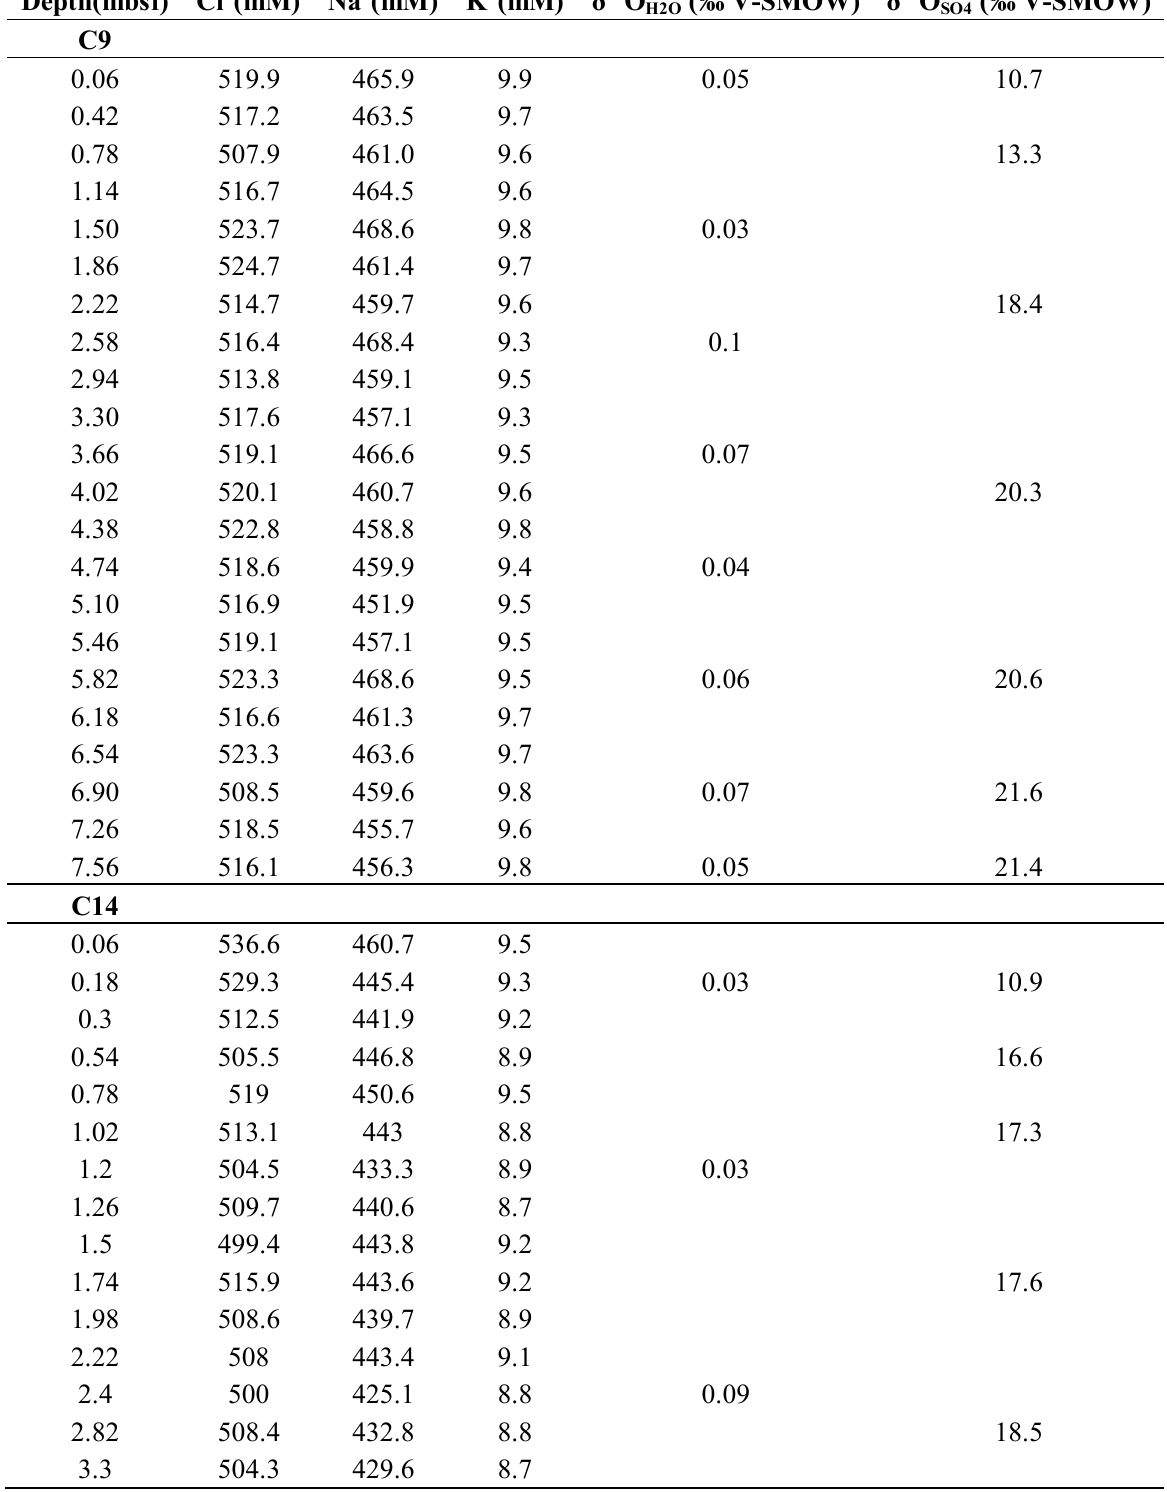
Table 1. Variations of the concentrations of Cl − , Na + , and K + as well as δ 18 O values of pore water and sulfate in C9 and